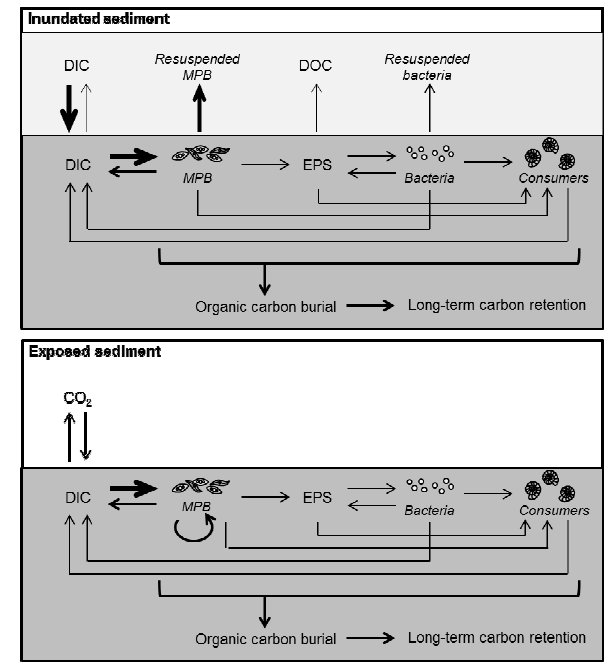
Fig. 5. Conceptual model showing pathways for the transfer of car- bon fixed by microphytobenthos in the subtropical intertidal sed- iments investigated in this study during inundation and exposure. Thicker arrows indicate pathways that, in the current study, were determined or estimated to be more dominant over 31